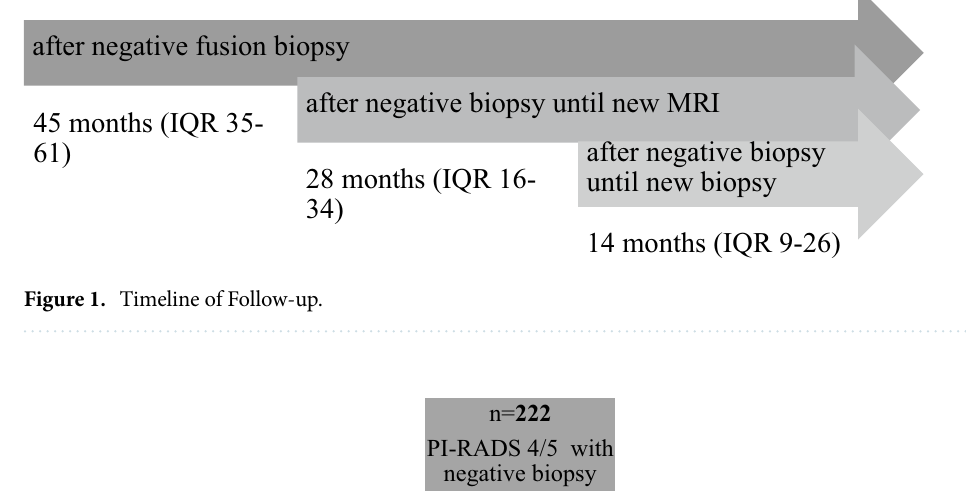
Figure 1. Timeline of Follow-up.